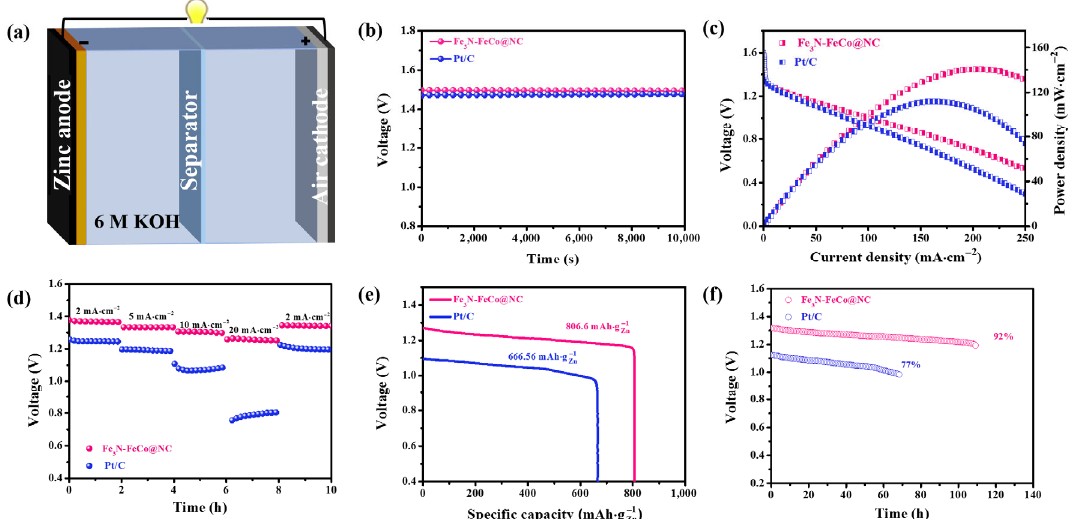
Figure 5 (a) Schematic of the primary Zn-air battery. (b) Open circuit voltages, (c) power density curves, (d) galvanostatic discharge at various current densities, (e) specific capacities, and (f) galvanostatic discharge at 5 mA·cm −2 of the Zn-air batteries using Fe 3 N-FeCo@NC and Pt/C as air-electrodes, respectively, in 6 M KOH